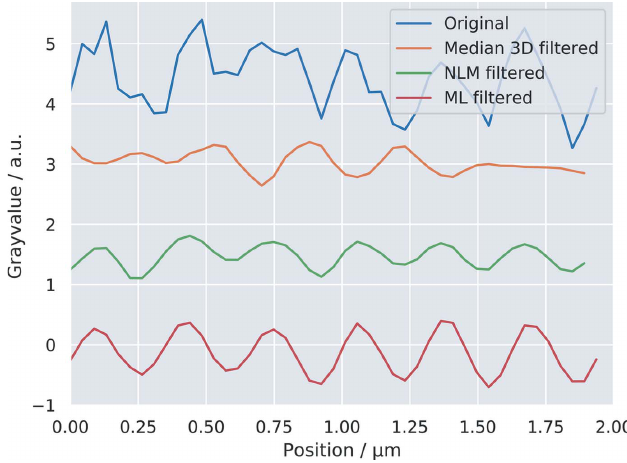
Figure 6 1D power spectral density (PSD) graph of the region of interest in Fig. 4 (2nd row). The periodic structure of the sample gives rise to frequencies around 0.004 nm (cid:6) 1